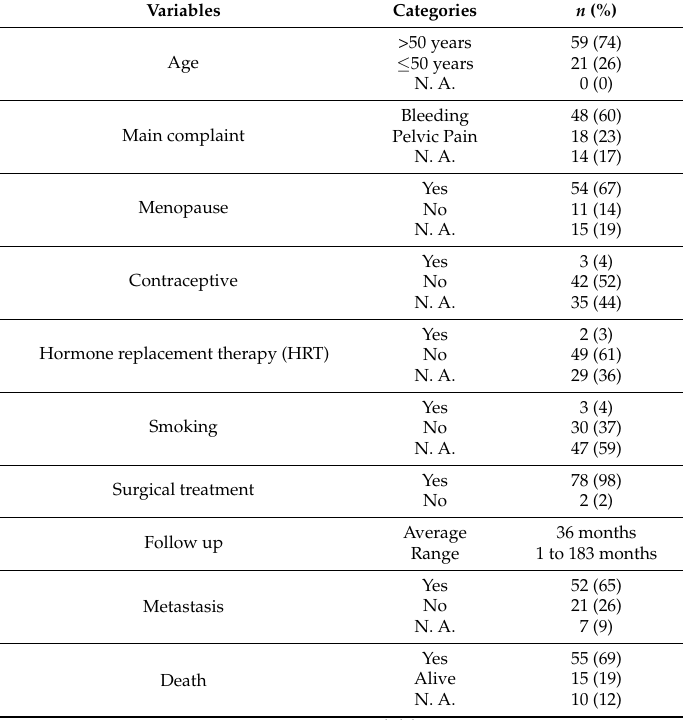
Table 1. Clinical pathological features of cancer patients ( n = 80) *.